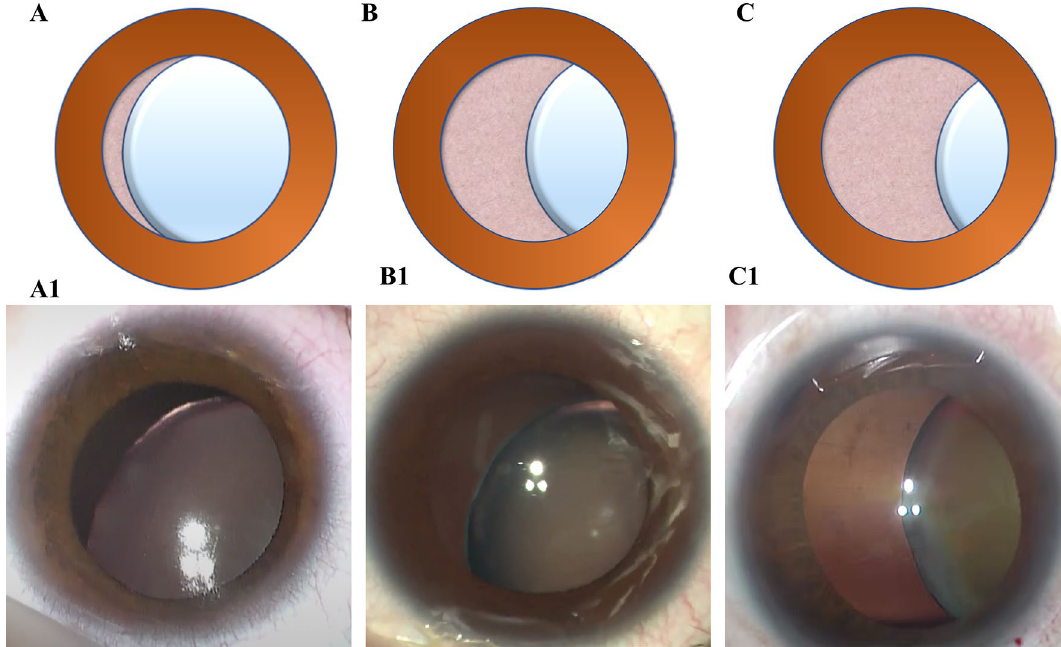
Figure 2. Different degrees of lens subluxation. ( A ) and ( A1 ). Mild: lens edge uncovered 0% to 25% of the dilated pupil; ( B ) and ( B1 ). Moderate: lens edge uncovered 25% to 50% of the dilated pupil; ( C ) and ( C1 ). Severe: lens edge uncovered greater than 50% of the dilated pupil. All images were taken during the operations by Doctor YX Jiang. Written informed consent was obtained from all the